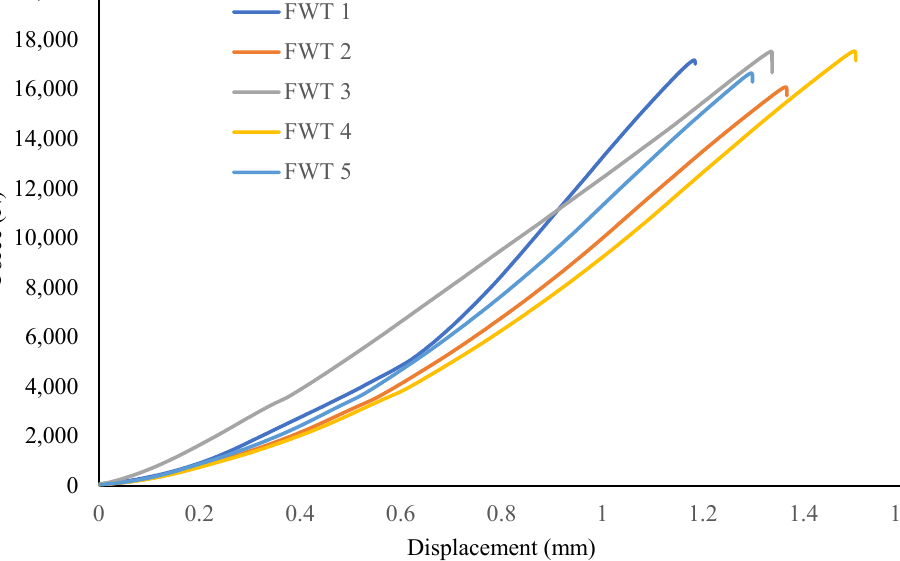
Figure 2. Load versus displacement curve for through-thickness specimens.